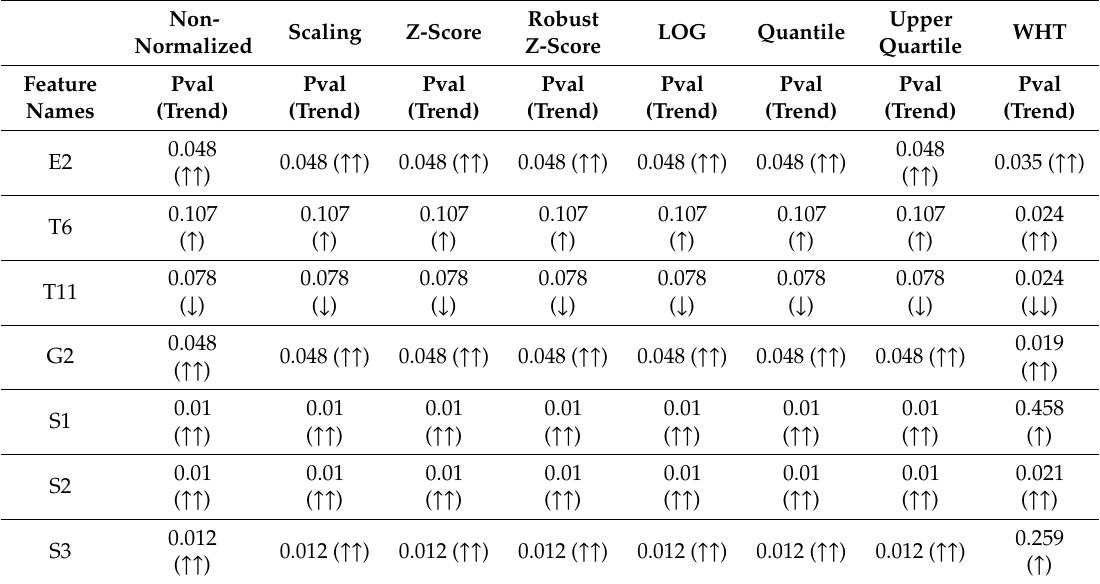
Table 6. Results from the Wilcoxon signed-rank test indicating association between MRI phenotype and molecular classification TN versus